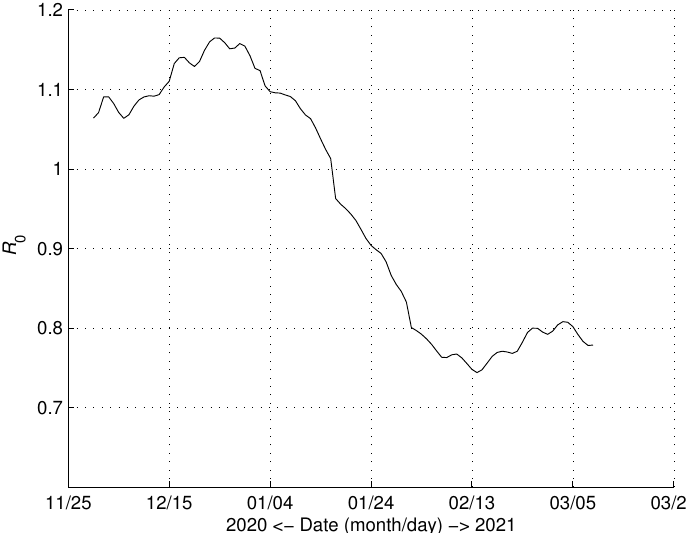
Figure 1. R 0 for Russia from 30 November 2020 to 9 March